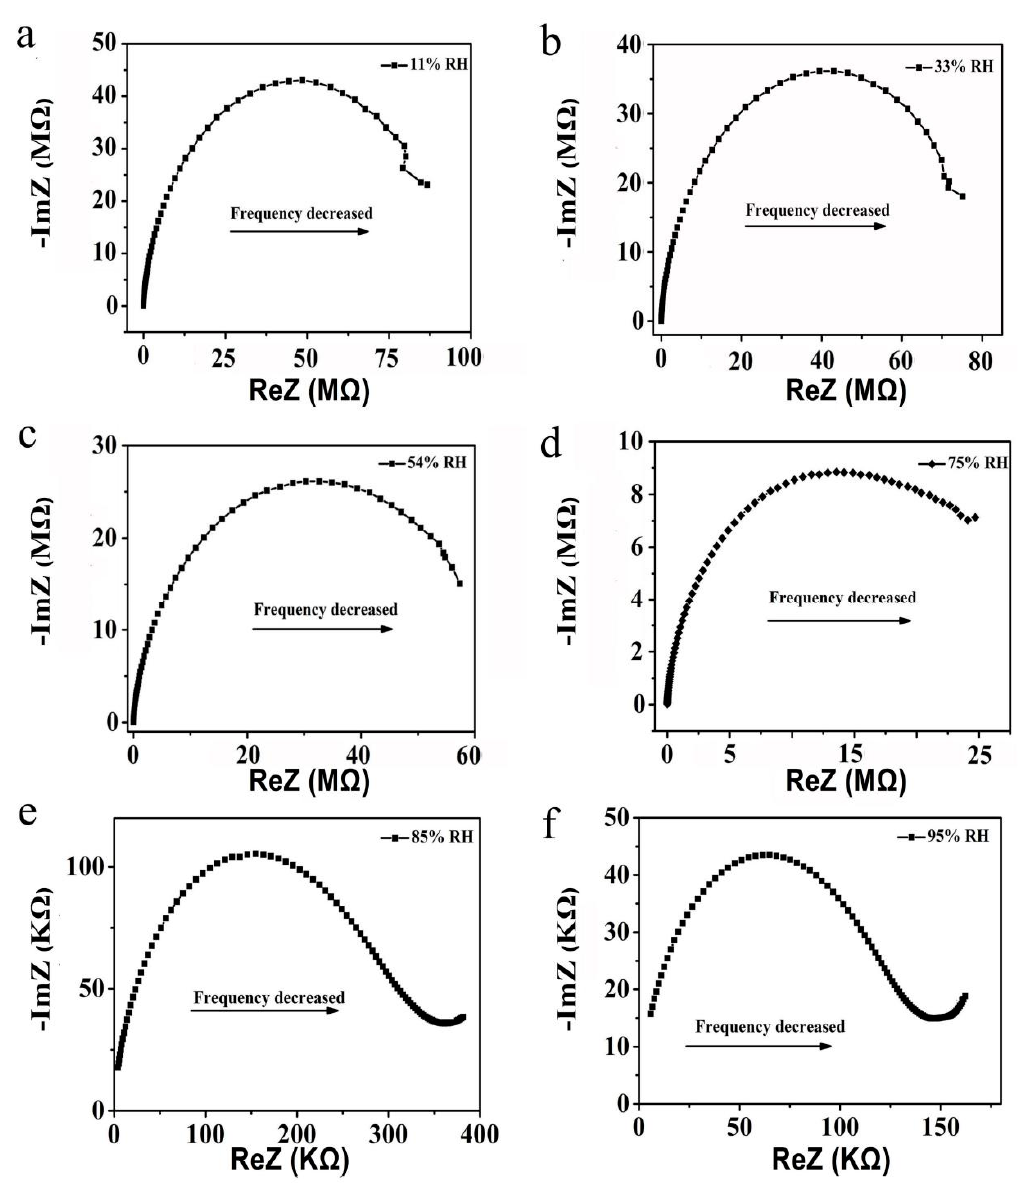
Figure 8. Complex impedance curves of Mg-doped ZnO microspheres (1.5 mol%) in ( a ) 11% RH, ( b ) 33% RH, ( c ) 54% RH, ( d ) 75% RH, ( e ) 85% RH and ( f ) 95% RH, respectively.